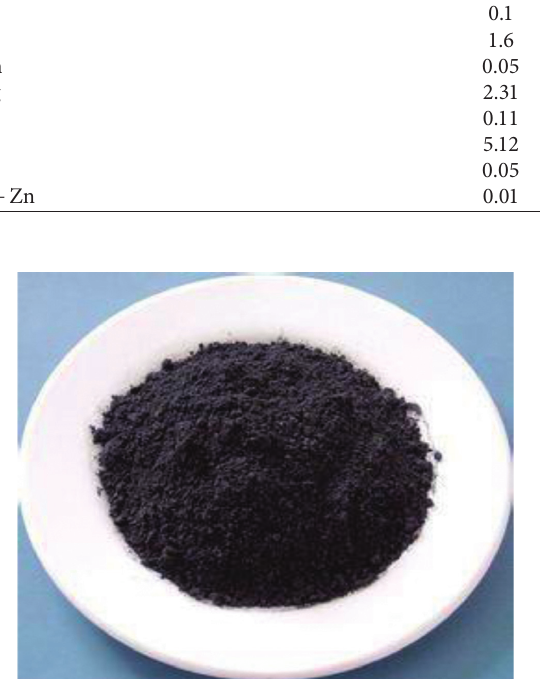
Figure 1: Titanium diboride.